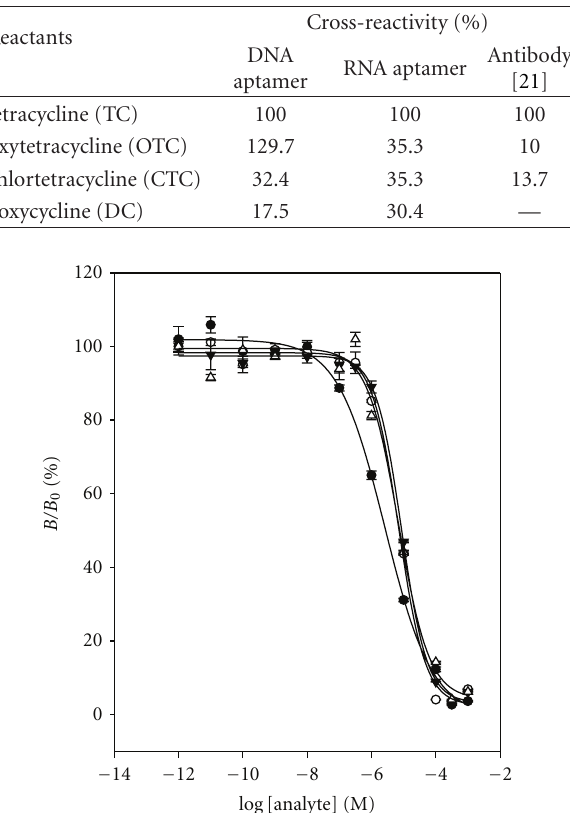
Figure 9: Cross-reactivity study with RNA aptamer for cross- reactants: ( • ) TC, ( ◦ ) OTC, ( (cid:3) ) CTC, and ( (cid:5) ) DC. Data points are means of triplicate